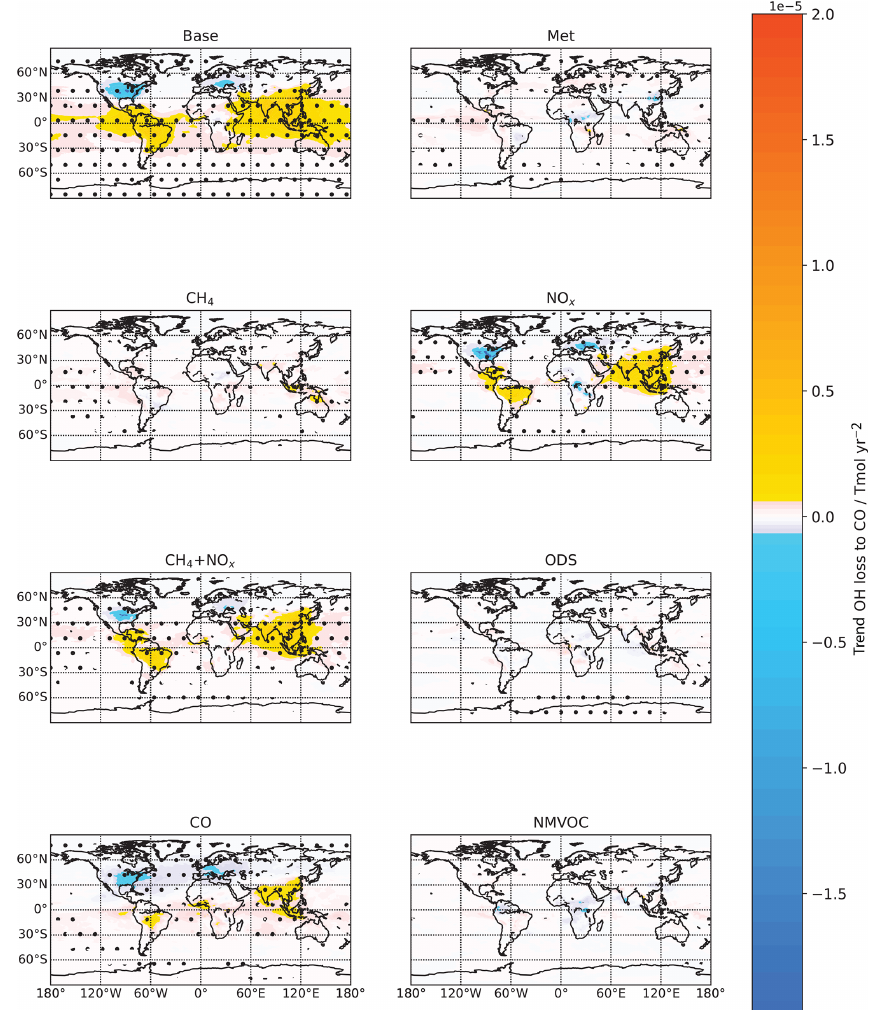
Figure 8. Tropospheric air-mass-weighted OH loss flux to reaction with CO spatial trends from 1980 to 2014 for the different model runs. Trends and stippling are as per Fig. 3. Regions of decreasing CO emissions see decreasing OH loss via reaction with CO and hence an increase in [OH] (as seen in the CO run in Fig. 3) and vice